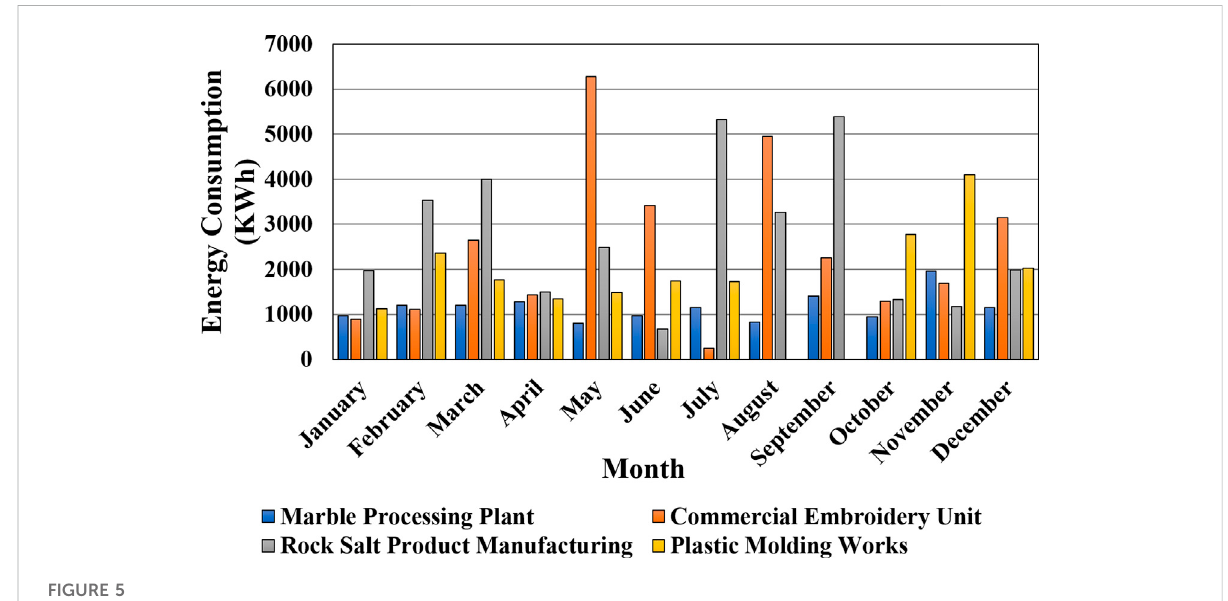
FIGURE 5 Monthly averaged electricity consumption of representative SMEs.